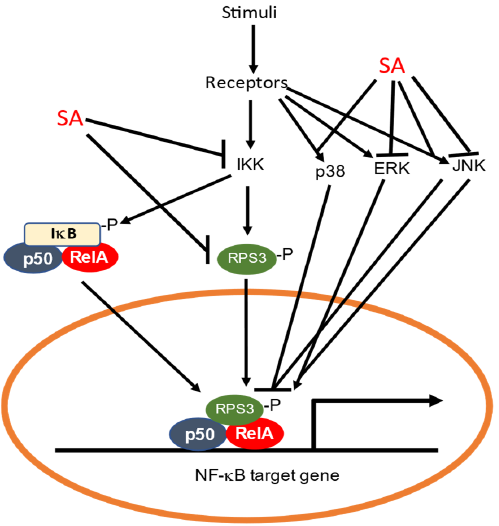
Figure 2. Inhibition of the NF-κB pathway by SA. SA can bind to and inhibit IKK, thereby preventing phosphorylation and degradation of IκB required for activation of NF-κB. Ribosomal protein RPS3 can translocate to the nucleus to activate NF-κB. SA also directly binds to RPS3 to prevent its translocation to the nucleus. The NF-κB pathway can also be inhibited or activated through the p38, ERK and JNK MAPK pathways, which are subjected to inhibition or activation by SA.